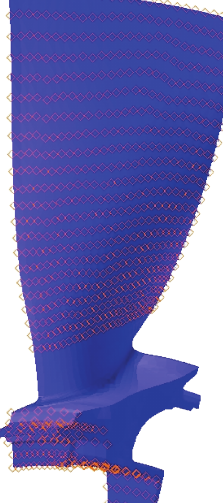
Figure 3: Retained nodes ♦ for the 1st